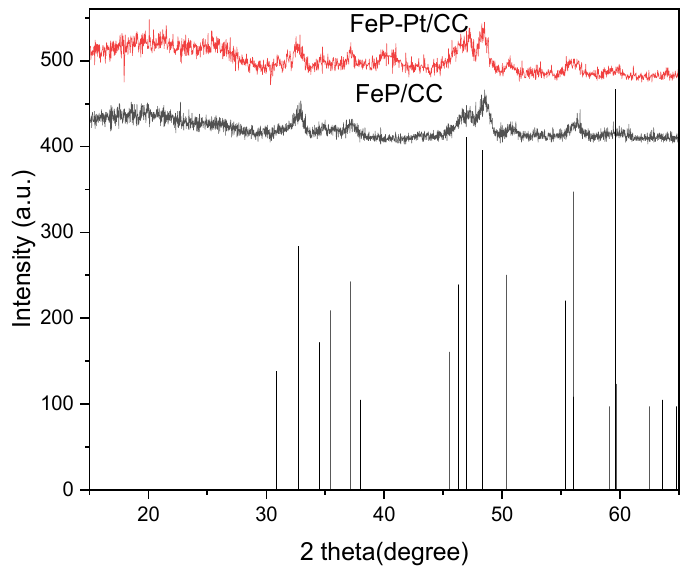
Figure 1. XRD patterns of the FeP/CC and FeP ‐ Pt/CC.